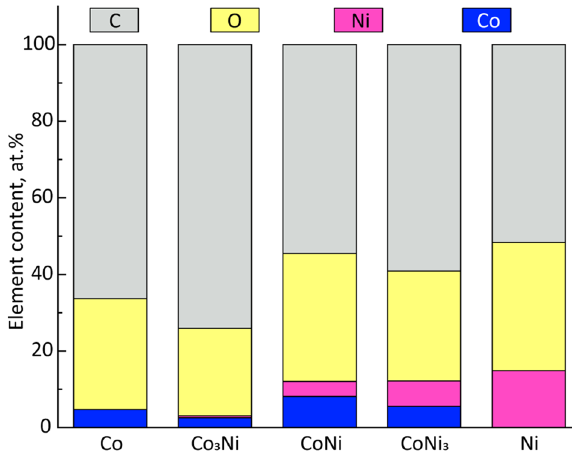
Figure 5. XPS calculated elemental content (at.-%) of the Co- and Ni-containing NPs.